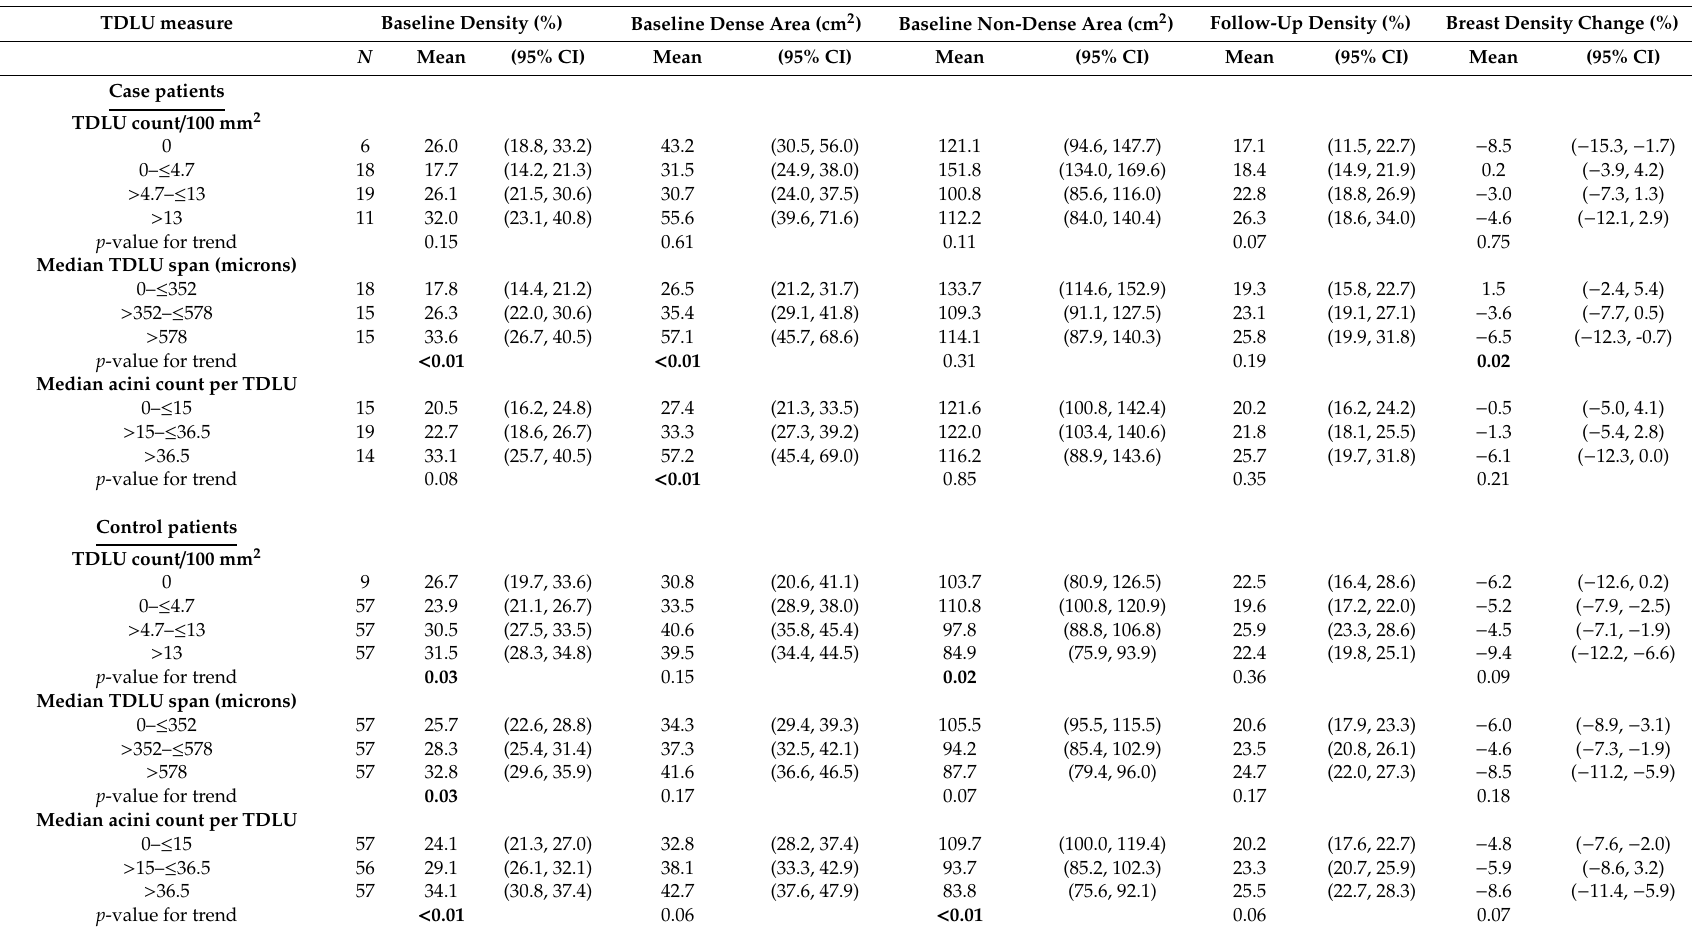
Table 3. Relationship between TDLU measurements and baseline and follow-up MD measurements among ER-positive case and control patients treated with tamoxifen. TDLU